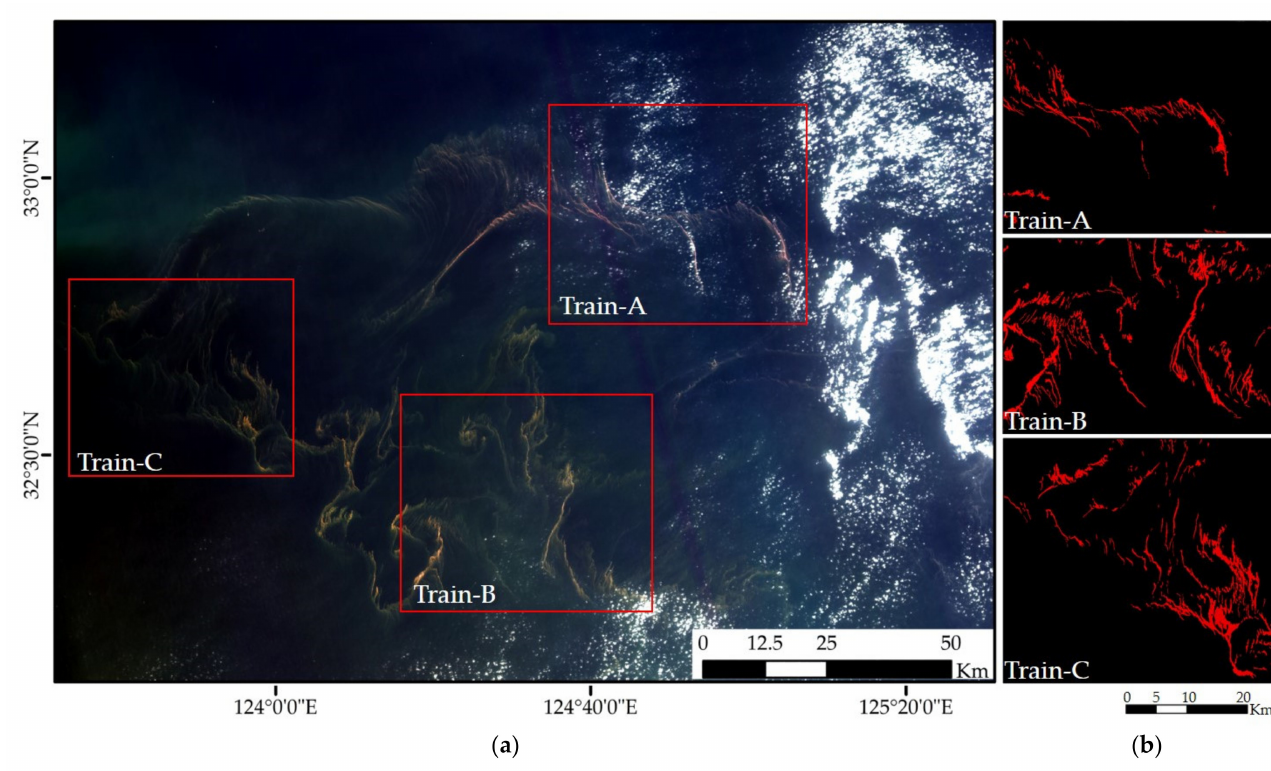
Figure 2. Location of training samples ( a ) and corresponding true values ( b ). The HY − 1D CZI images are true color composites of bands 3(R), 2(G), and 1(B). The red pixels in ( b ) represent red tides, while the black pixels represent seawater and